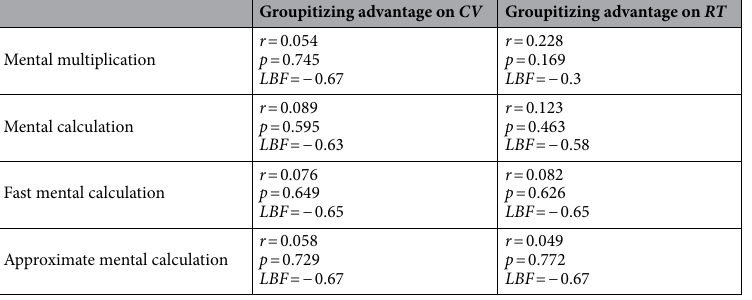
Table 2. Correlation between groupitizing advantage and arithmetic scores. Pearson correlations with associated two-tailed p-values and Log10 Bayes Factors ( LBF